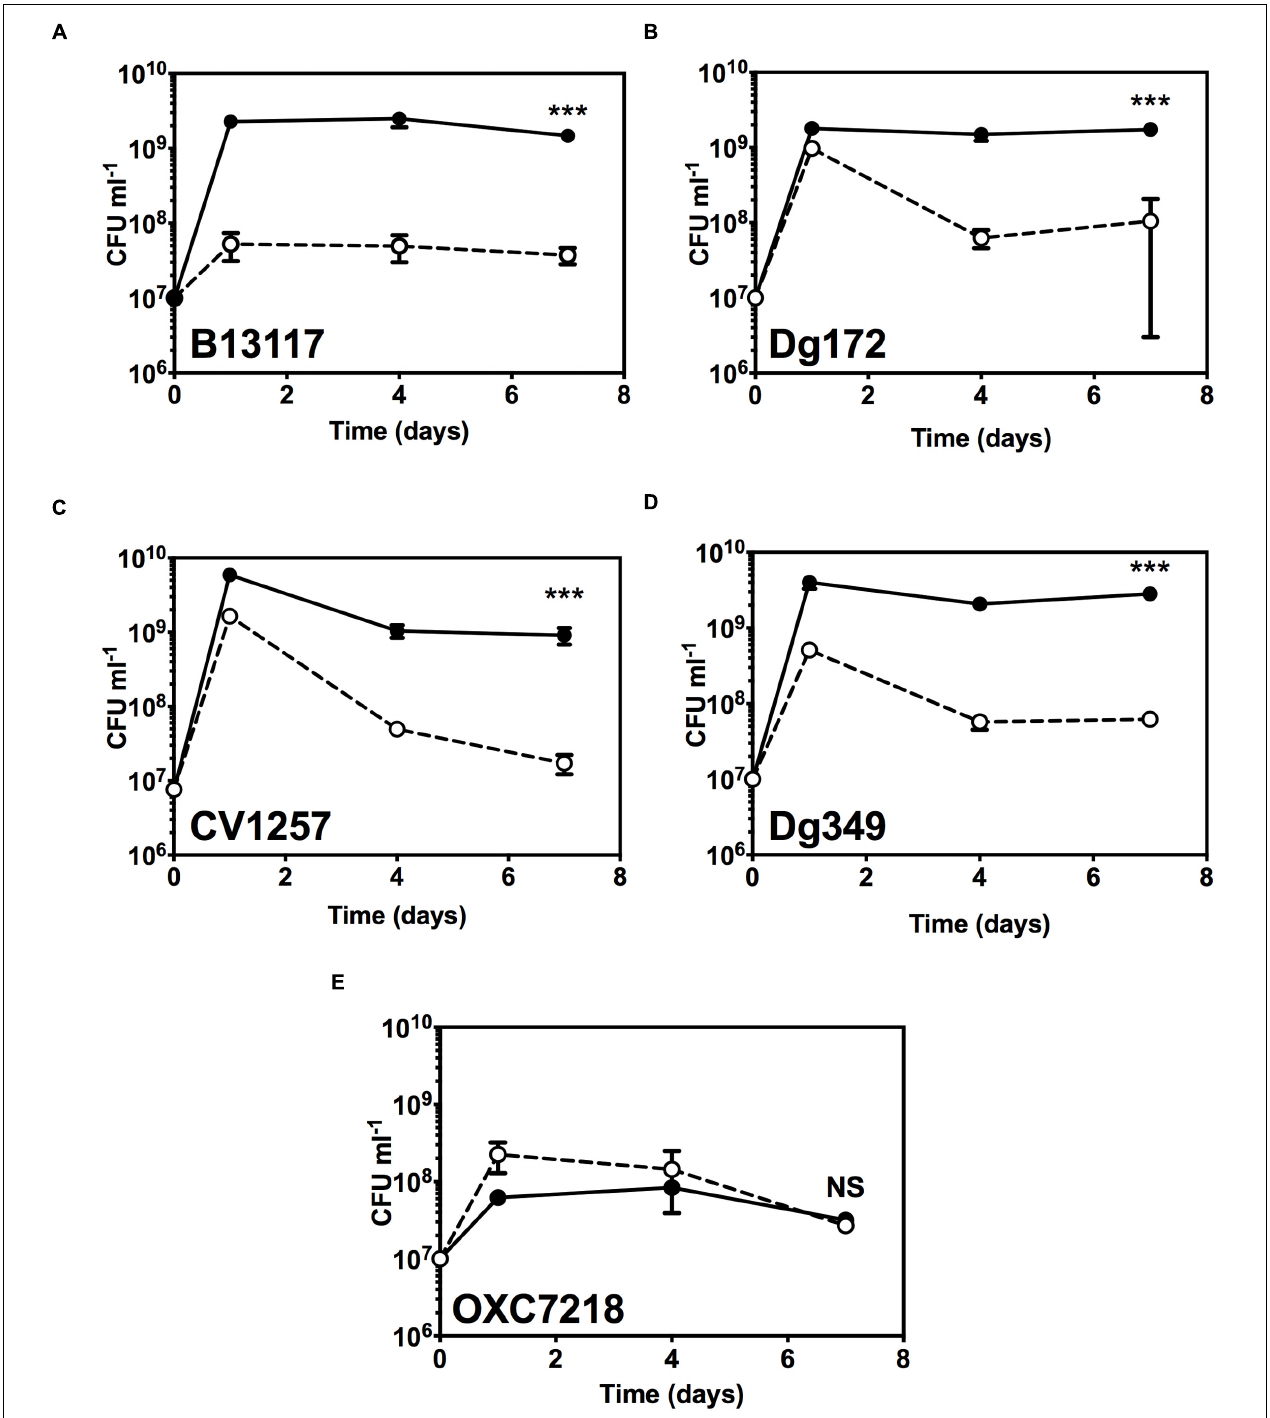
FIGURE 5 | Extended stationary phase survival with glucose. Viable cell numbers of ED-positive C. coli isolates (B13117, CV1257, Dg172, and Dg349) and an ED-negative control C. coli strain (OXC7218) were determined in TSB with or without supplementation with 100 mM glucose. Cultures were incubated for 7 days at 37 ◦ C in microaerobic conditions and the viability determined by enumerating CFU at various time intervals. Results are mean and standard deviations of three independent cultures. The error bars are too small to be seen in some cases. (A) C. coli B13117; (B) C. coli CV1257; (C) C. coli Dg172; (D) C. coli Dg349; (E) C. coli OXC7218 (ED-negative control). Open circles and dashed line, cell numbers without glucose; filled circles and solid line, cell numbers with glucose. The statistical significance of the difference between the control without glucose and with added glucose at 7 days was tested by Student’s t -test, as indicated by ( ∗∗∗ p < 0.001) or NS (not